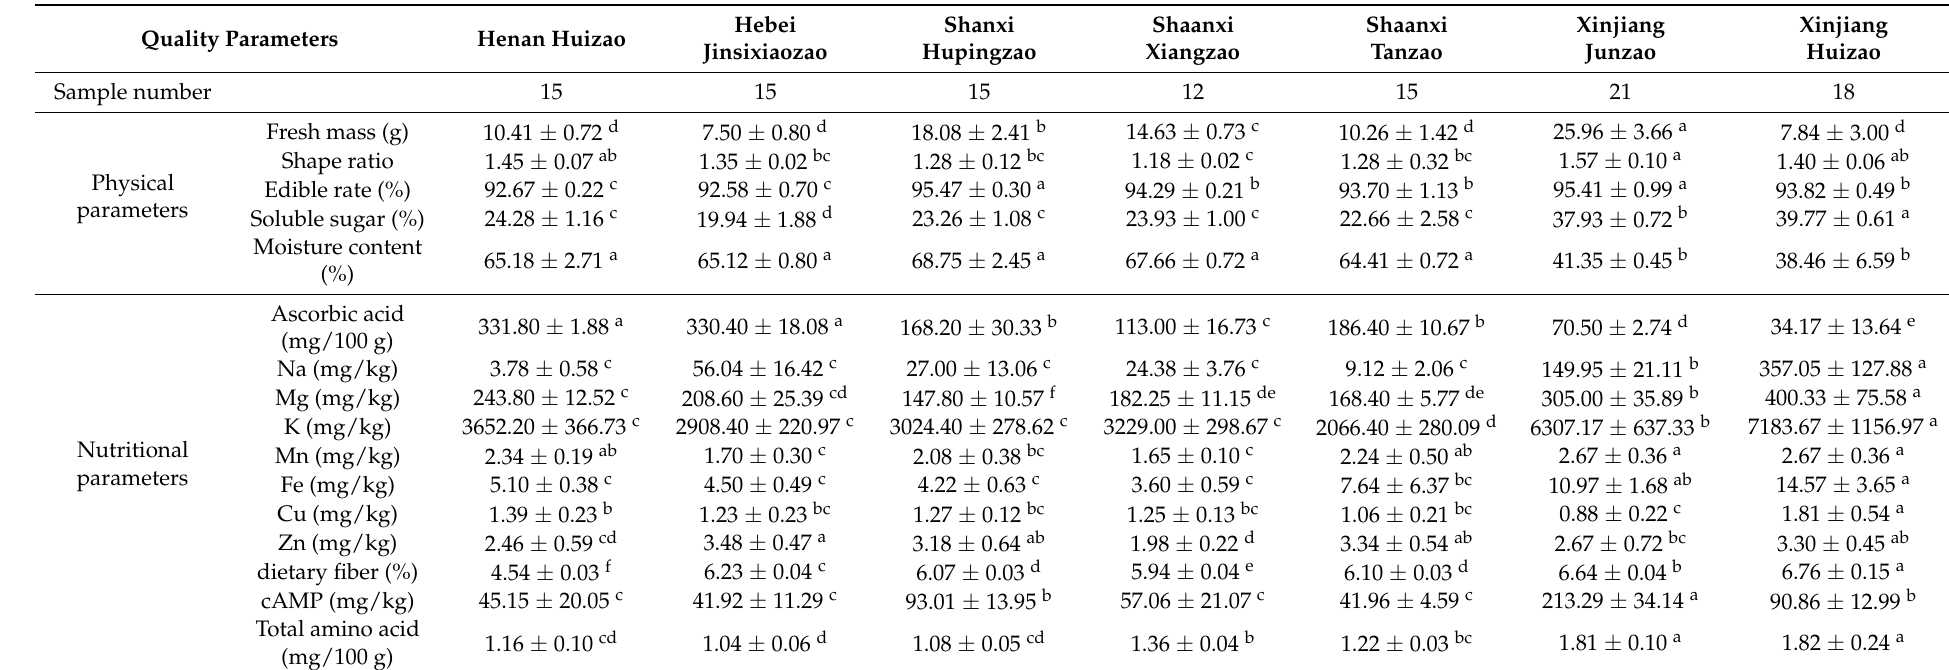
Table 1. Determination of 16 physical and nutritional parameters in Chinese jujubes from different